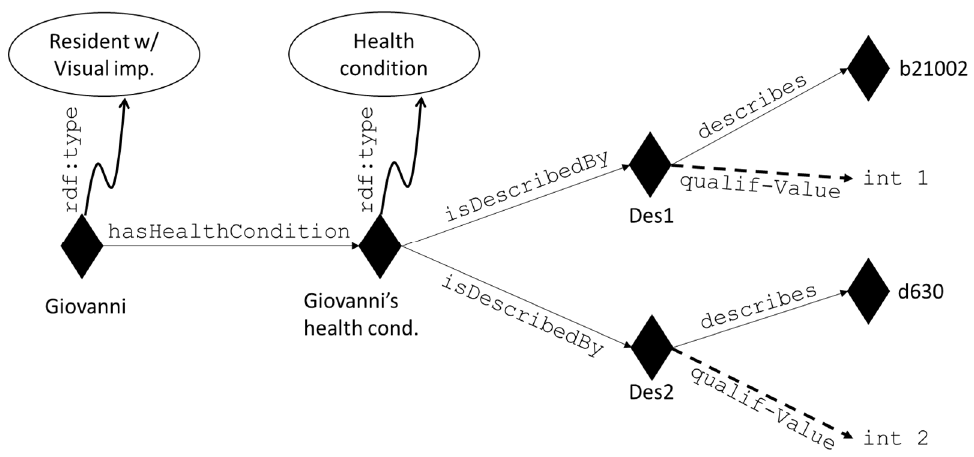
Figure 3. An excerpt of the modelling of Giovanni’s health condition; individuals are represented with diamonds, concepts are represented with circles, and roles are represented with arrows (dashed arrows indicate datatype properties, full-line arrows represent object properties). The type of an individual is stated with a curved arrow.